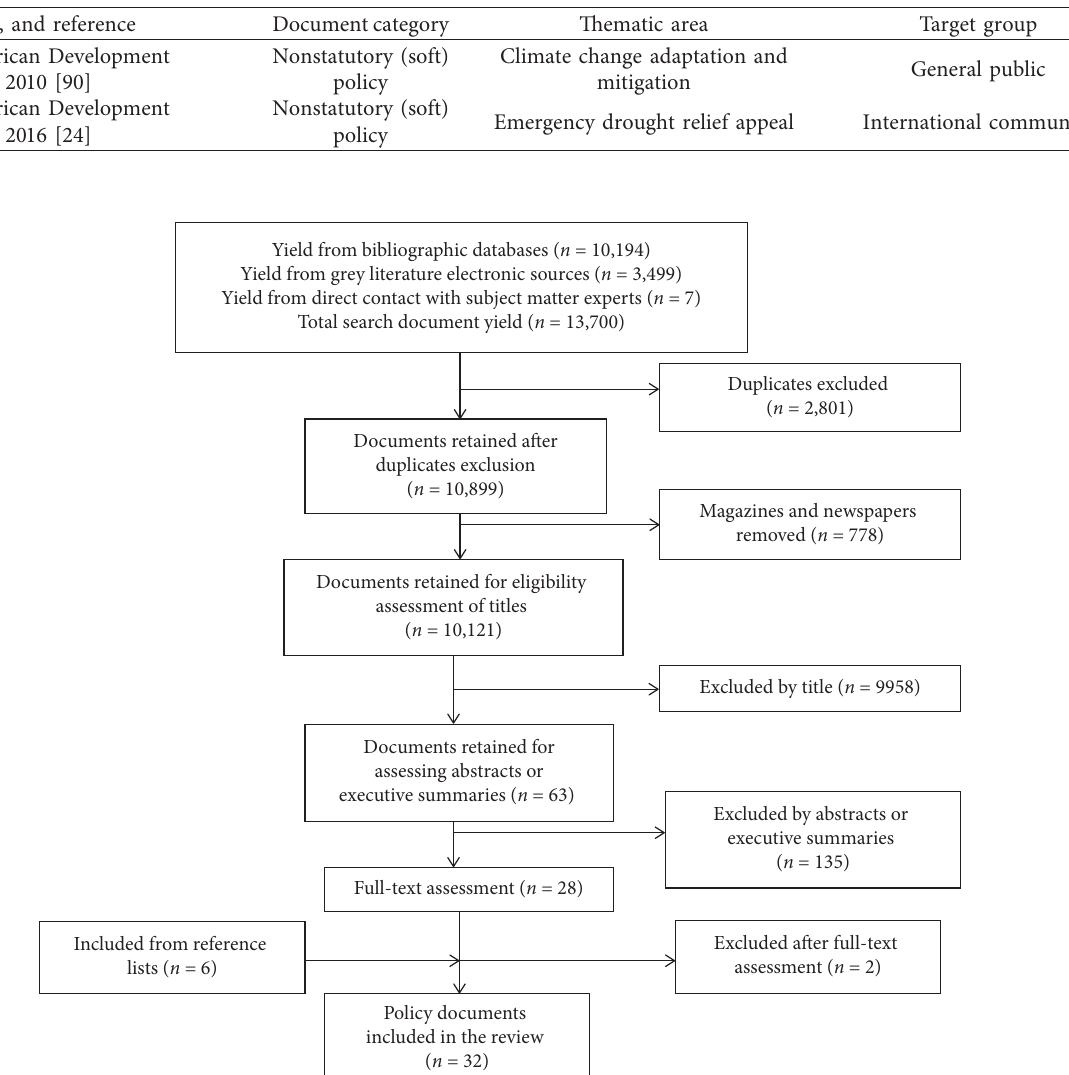
Figure 1: Policy document selection